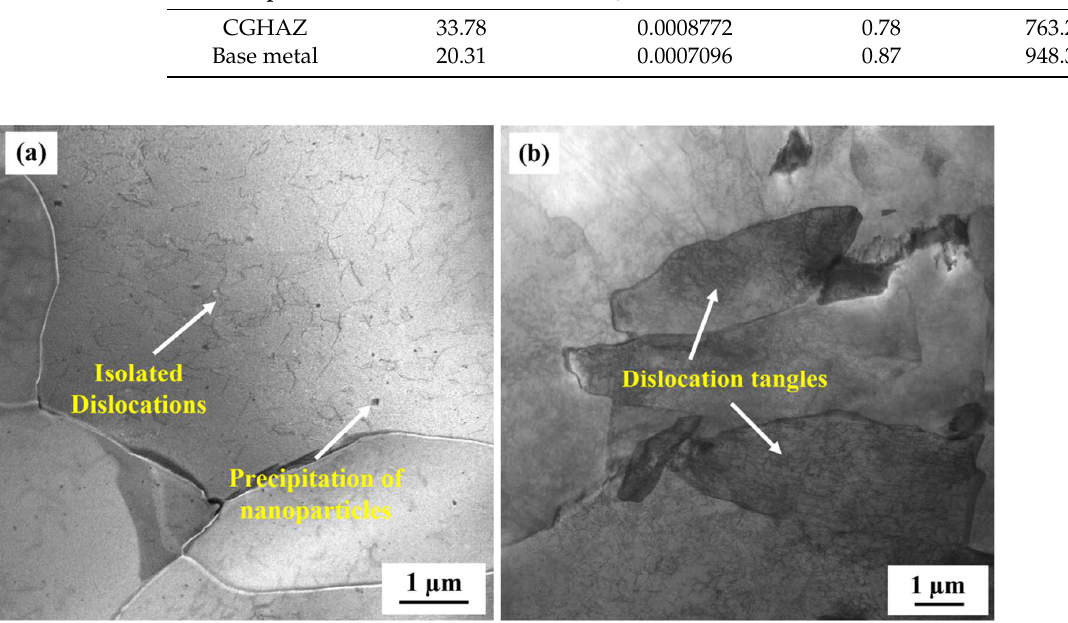
Figure 7. TEM morphologies of the tested steel; ( a ) base metal and ( b )